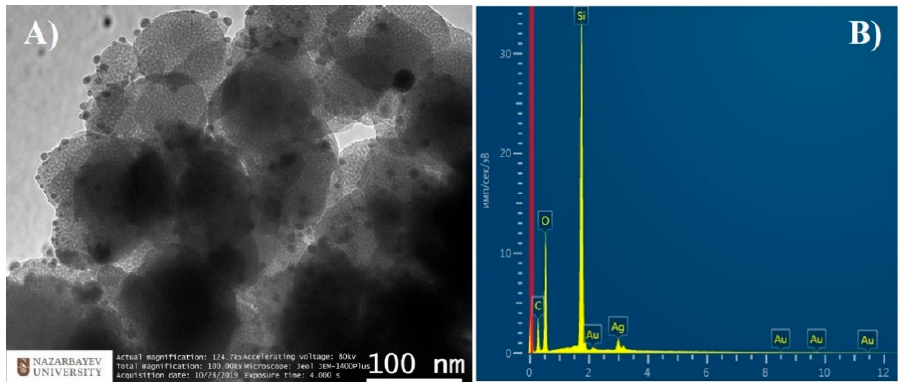
Figure 1. ( A ) TEM image and ( B ) EDX analysis of mesoporous silica nanoparticle (MSN)/Ag nano ‐ composite.